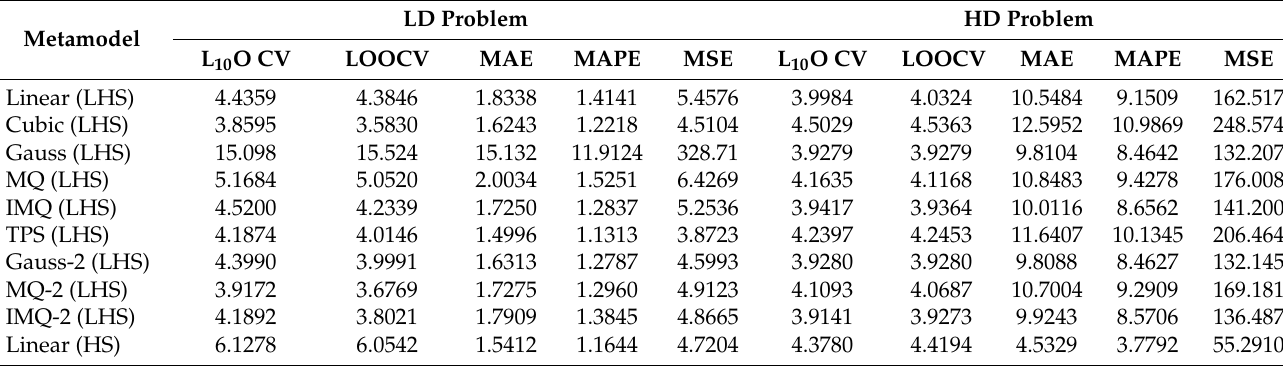
Table A3. Comparison of all metamodels based on various metrics for third